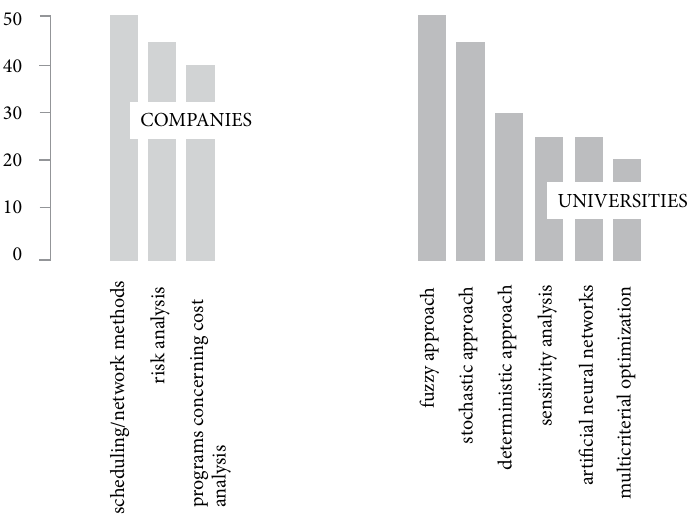
Fig. 4. Recommendations by Polish building companies and academic teachers and research institutes